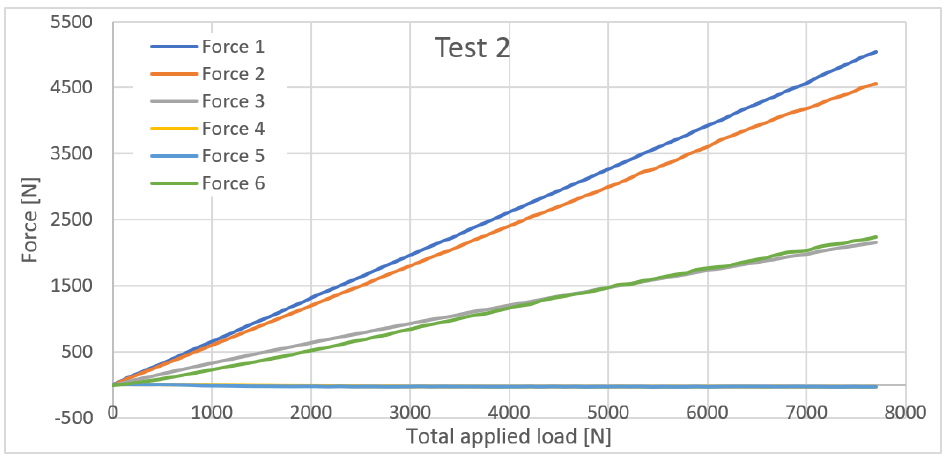
Figure 12. Total force redistribution into individual load cells during test two.